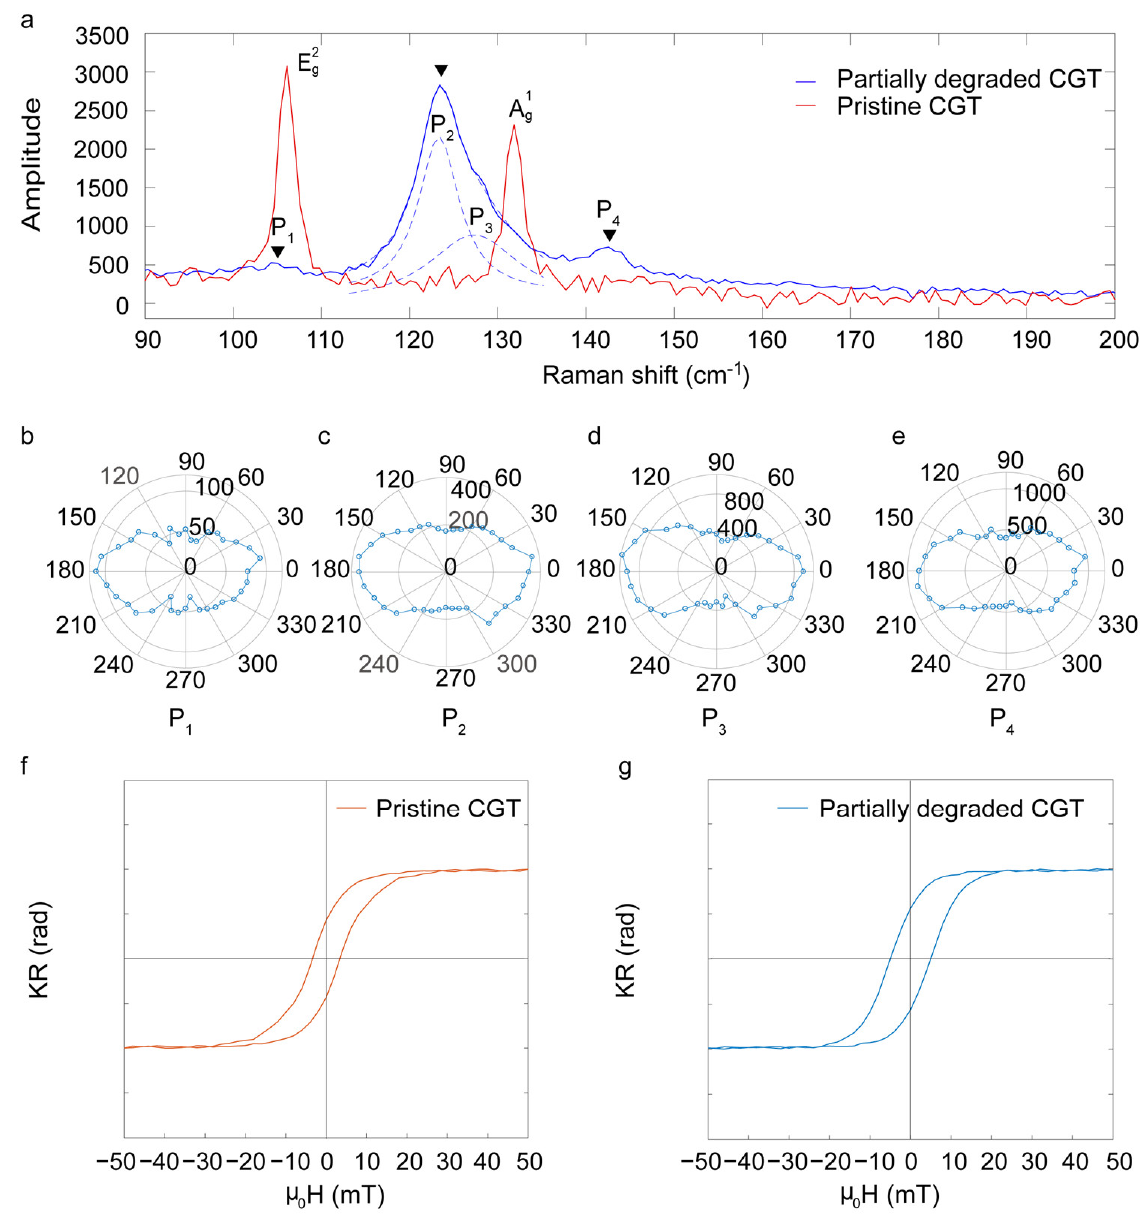
Figure 2. ( a ) Raman spectrum of pristine CGT and partially air-degraded CGT taken at T = 294 K. ( b – e ) are the polarization angle-dependent Raman intensity of the P1, P2, P3, and P4 modes, respec- tively. ( f ) Magnetic hysteresis loop of pristine CGT at 10 K. ( g ) Magnetic hysteresis loop of partially degenerated CGT at 10